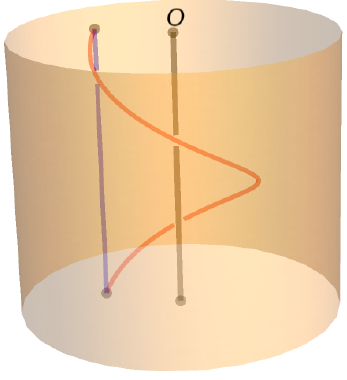
Figure 10. The paths are homotopic, but only through a homotopy that encounters O × I